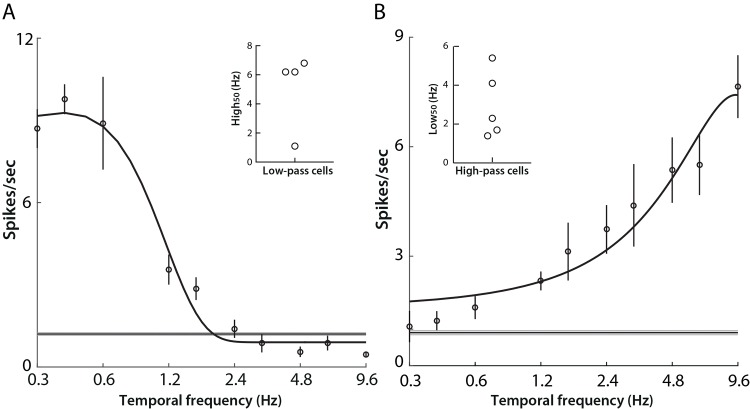
Low-pass and high-pass temporal frequency tuning.A) An example of a cell showing low-pass temporal frequency tuning. Open circles indicate mean firing rates across four repeated presentations of drifting gratings (high50 1.1 Hz). Black curves show the best fits of a two-half-Gaussian function. Grey areas represent SEM of spontaneous activity, with thinner lines indicating mean. Inset: high50 of all low-pass cells. B) An example of a cell showing high-pass temporal frequency tuning (low50 1.4 Hz). Inset: low50 of all high-pass cells.